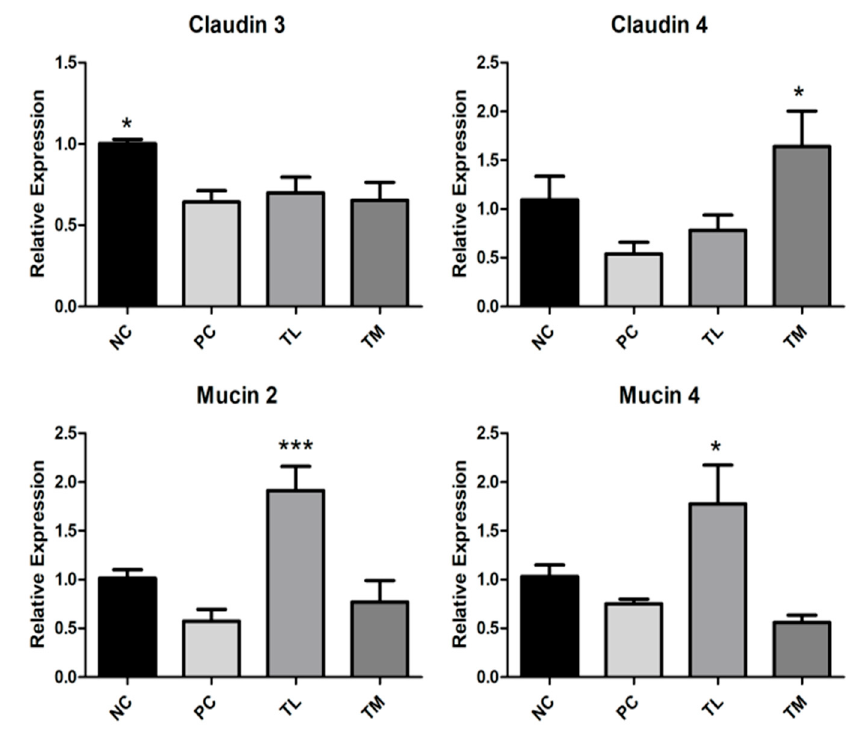
Figure 4. Effect of IMD on expression of tight junction proteins Claudin 1-5, 7, occlaudin, as well as mucin 2 and mucin 4 relative to GAPDH, as determined by RT-PCR. Results are expressed as mean ± SEM for n = 6 samples for each group. Differences between means were considered significant for * p < 0.05, ** p < 0.01, or *** p < 0.001 relative to PC.